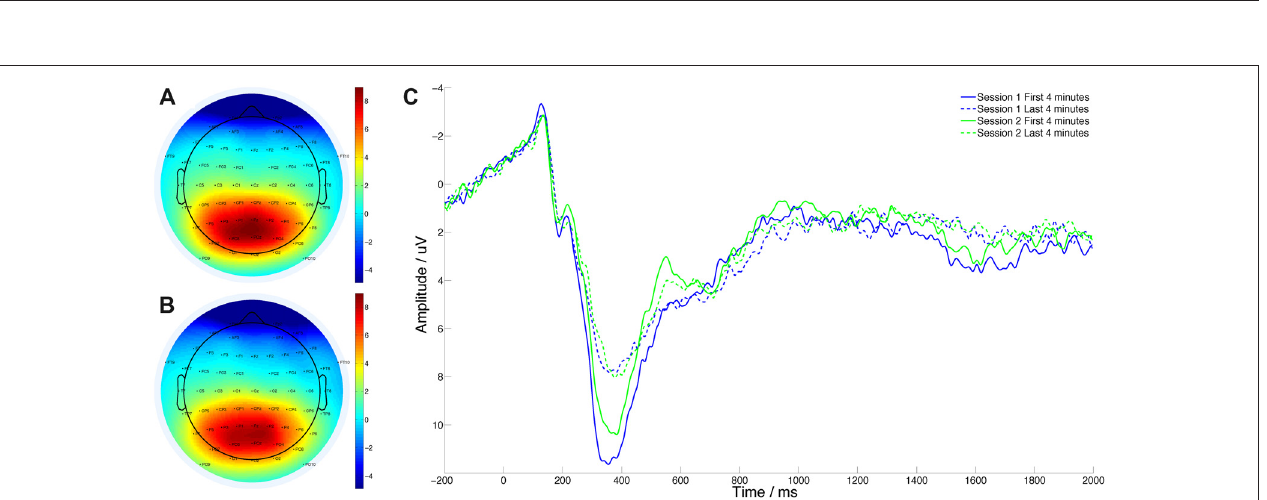
lapses in S2 PVT (40), 3.5 SD. over the mean; this dataset